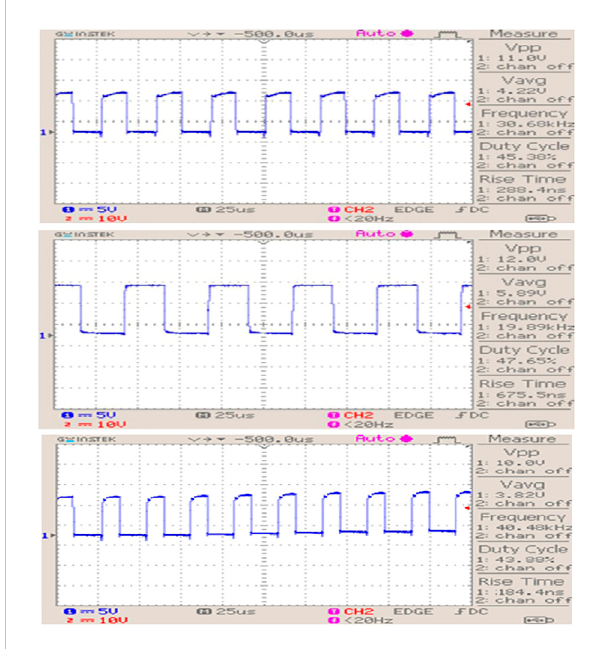
FIGURE 13 Duty cycle of boost converters fed with solar, fuel cell, and battery.